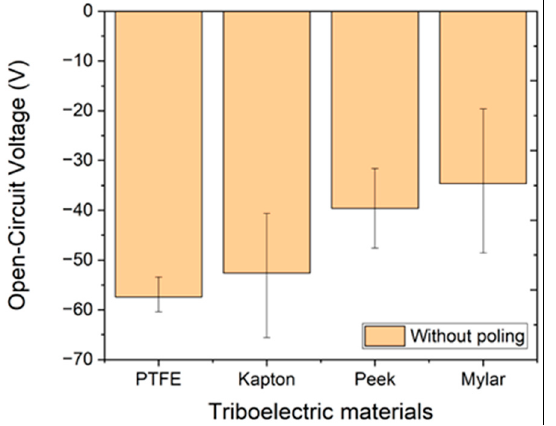
Figure 3. Comparison of voltages generated for the different material samples.